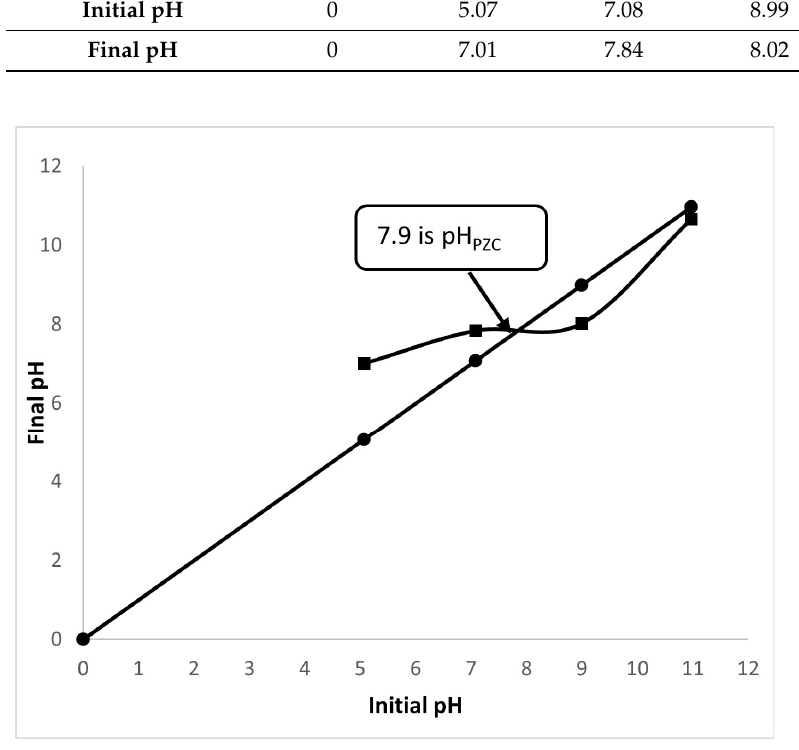
Figure 9. Point of zero charge (pH PZC ) of Ag-TiO 2 /rGO/HNT.